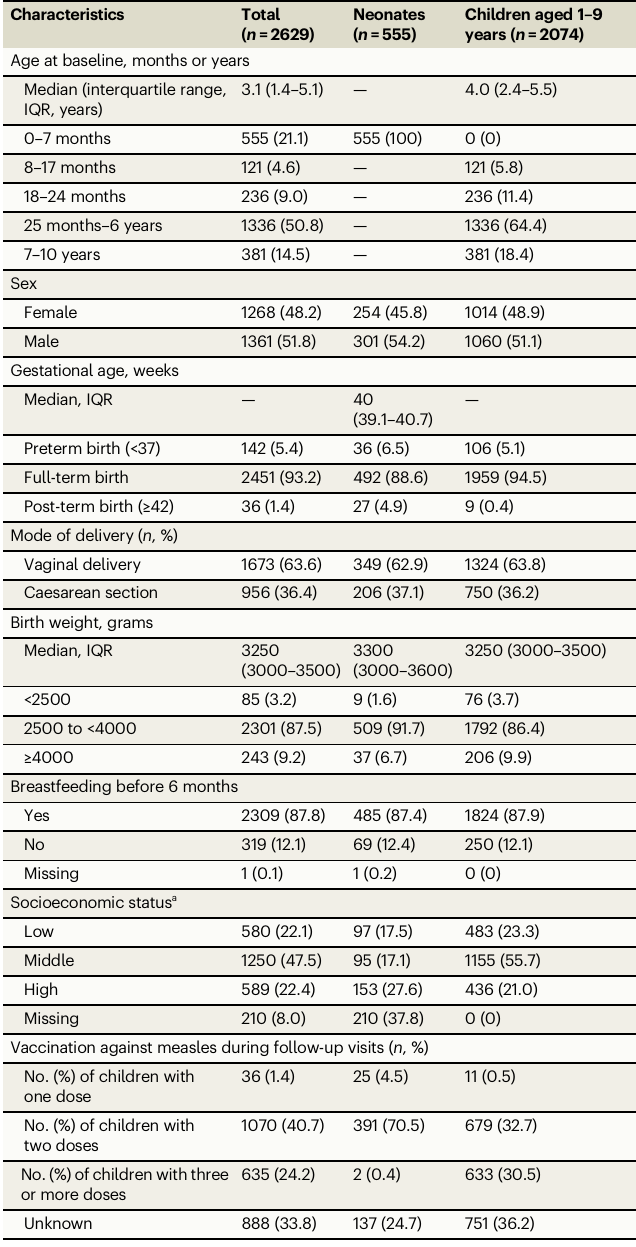
Table 1 | General characteristics of the children